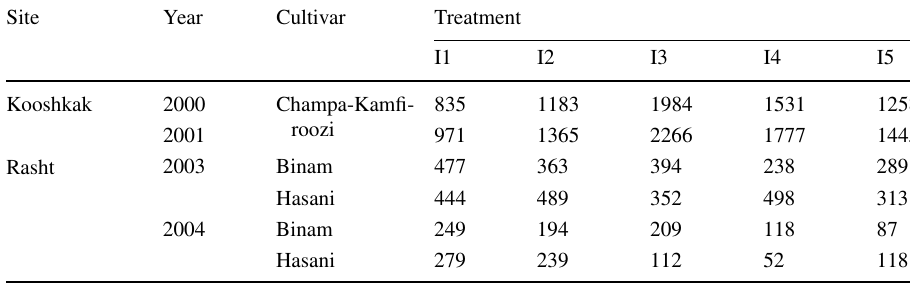
Table 3 Amounts of applied irrigation water (mm) during the growing